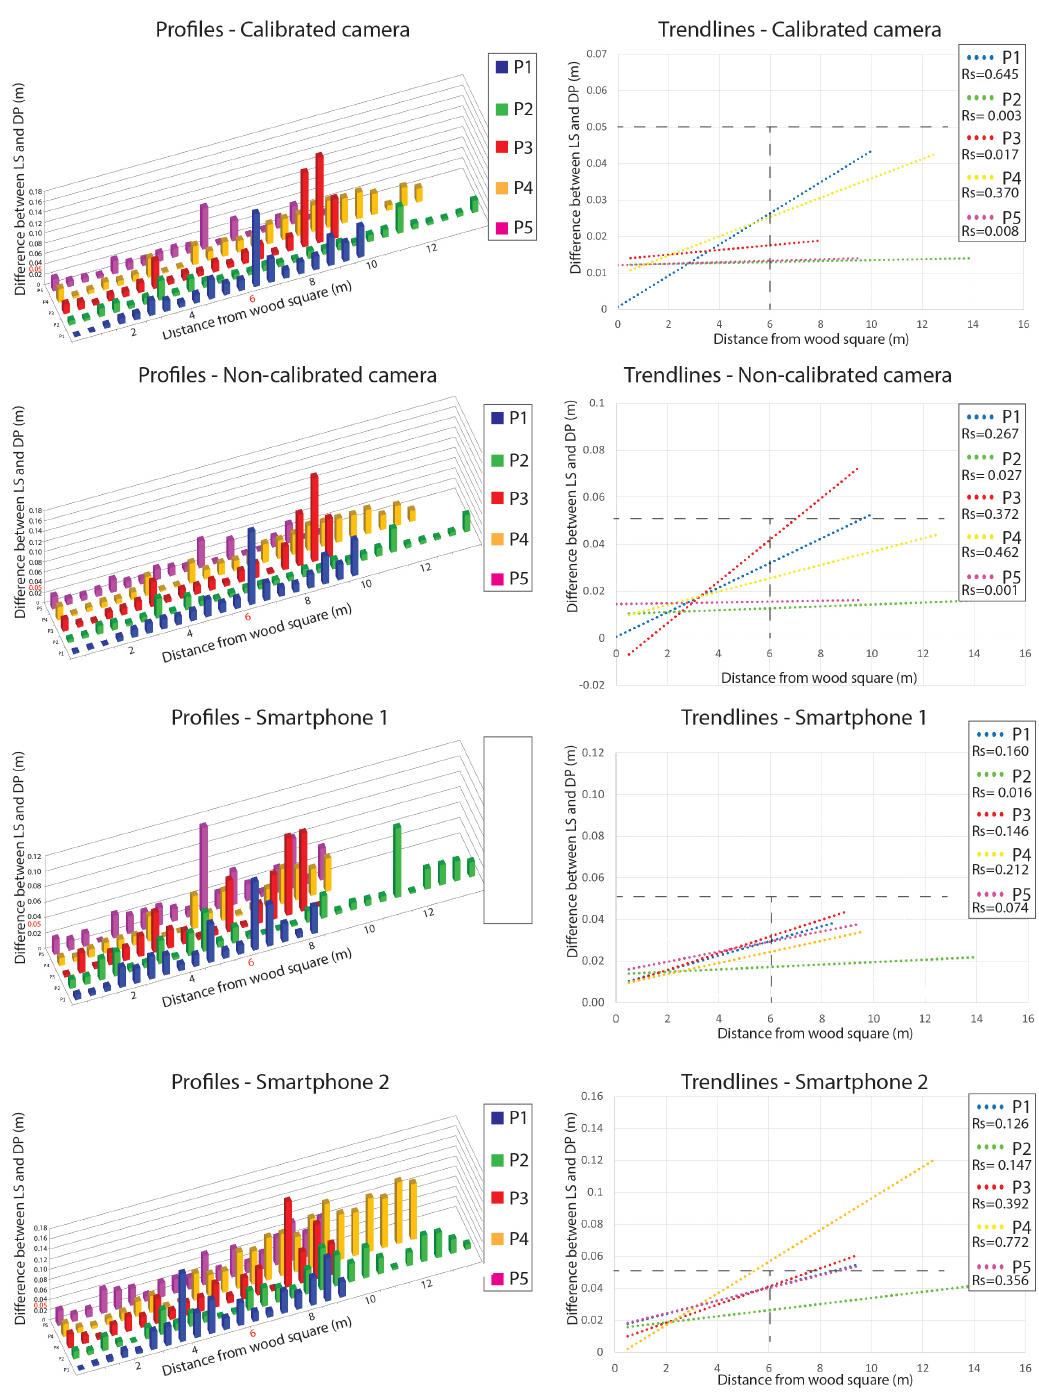
Figure 9. Column charts (left) and trendline graphs (right) obtained from a comparison between the LS and the calibrated camera, non-calibrated camera, smartphone 1 and smartphone 2 models. All models were georeferenced using the five targets 1–5 located on the wooden square. For references, we have included the black dashed lines in the trendline graphs at a distance of 6 m from the wooden square and for indicating a 0.05 m di ff erence between the LS and DP. In the column charts, 6 m of distance and 0.05 m of di ff erence are highlighted in red. Rs in the trendline graphs indicates the R square